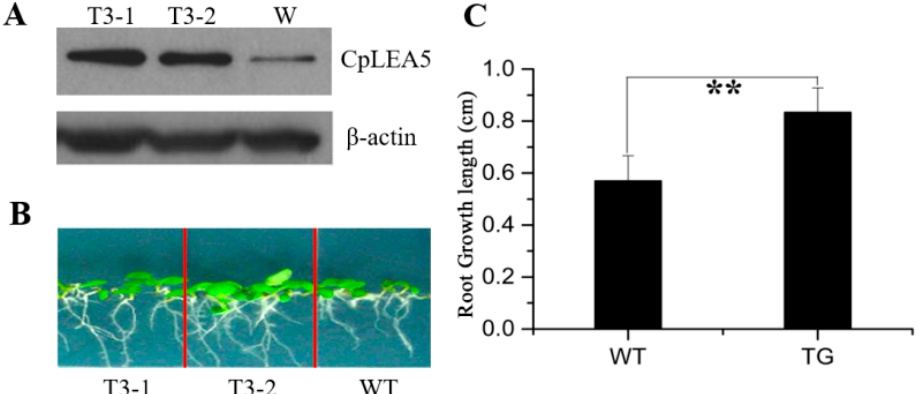
Figure 6. Drought resistance assay in CpLEA5 -transformed Arabidopsis plants . ( A ) Western-blot analysis of the two independent transgenic lines (T3-1, T3-2) and wild-type line (W); ( B ) Drought stress simulated with mannitol; ( C ) Root growth length after seven days drought stress. Data are means ± standard deviation of three replications. ** Significant difference at p < 0.01. WT, wild-type; TG, transfornant.